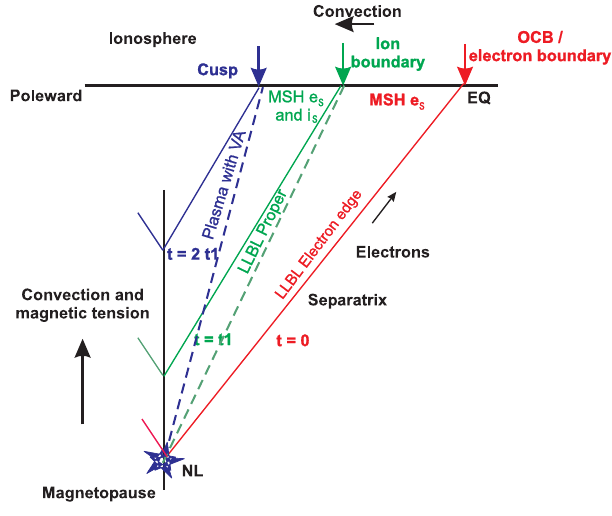
Fig. 1. Simplified schematic view of the evolution of magnetic field lines following reconnection, and the corresponding plasma regions at mid-altitudes or in the ionosphere. In this figure, all field lines have been straightened so that the magnetopause is represented by the vertical black line towards the left of the figure, and the iono- sphere by the horizontal black line towards the top. The blue star shows location of the reconnection at the magnetopause. The red line represents a newly reconnected field line with time history since reconnection t = 0. This line is the separatrix between closed and open field lines and also represents the electron equatorward bound- ary of the LLBL/cusp. The green line represents an older recon- nected field line with time history since reconnection t = t 1 along which the most energetic magnetosheath ions have arrived at mid- altitudes. The trajectory of these energetic ions is indicated by the dashed green line. This line represent ion equatorward boundary of the LLBL/cusp. Due to the magnetic tension, this line will convect away from the reconnection site, as indicated by the green solid line. The blue line represents an even older field line, with time history since reconnection t = t 2 , along which the bulk plasma flow accel- erated at the magnetopause up to the local magnetosheath Alfv´en velocity will arrive at mid-altitudes. The trajectory of the plasma bulk flow is indicated by the dashed blue line. This line marks the equatorward boundary of the cusp proper. The region between the electron and ion boundaries of the LLBL/cusp is named the electron edge of the LLBL and contains only magnetosheath-like electrons but still magnetospheric ions. The region between the ion boundary of the LLBL/cusp and equatorward boundary of the cusp proper is the LLBL proper, containing both accelerated magnetosheath-like electrons and ions. The region poleward of the equatorward bound- ary of the cusp is the cusp